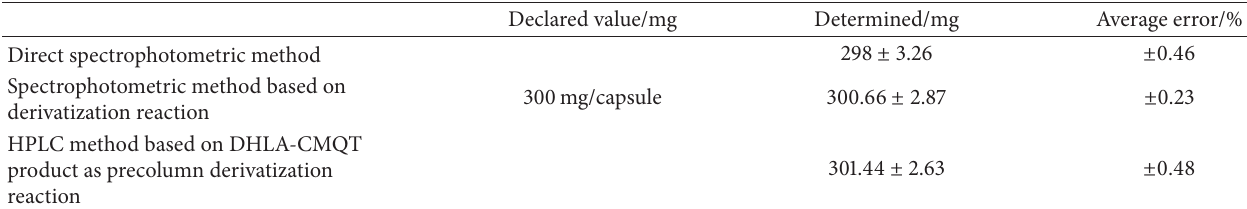
Table 3: Assay results of the commercial lipoic acid dosage forms; 𝑛 = 5